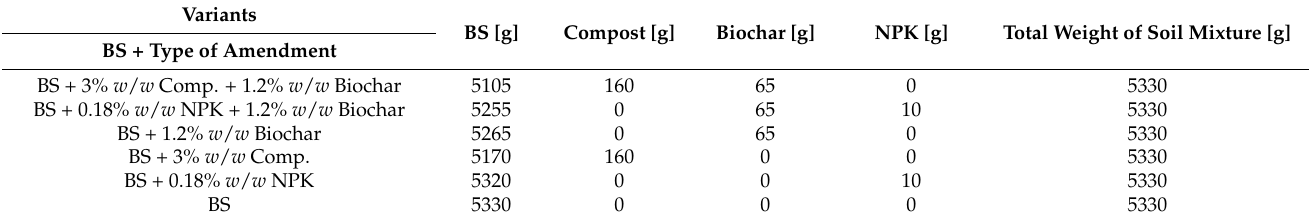
Table 2. Weight of soil amendments in individual variants and pot experiment arrangement.